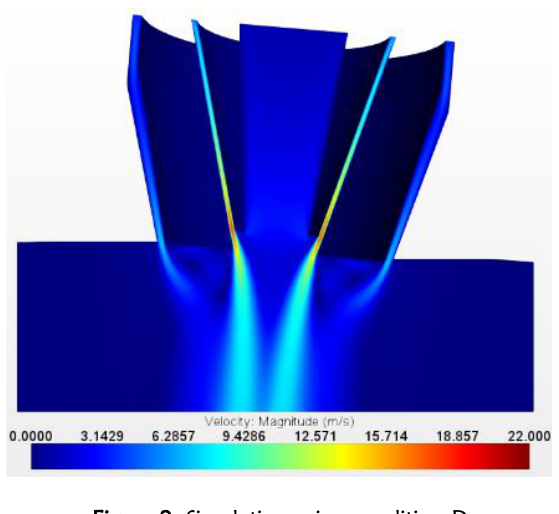
Figure 9: Simulation using condition D